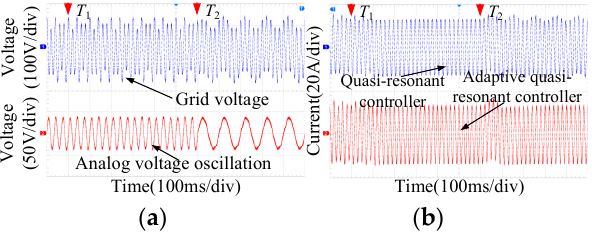
Figure 20. Comparison of the waveforms of the oscillation suppression effects of the two resonant controllers: ( a ) grid voltage oscillation waveform; ( b ) stator current waveform comparison. Finally, the inhibition effect of the proposed SSO inhibition strategy was verified.